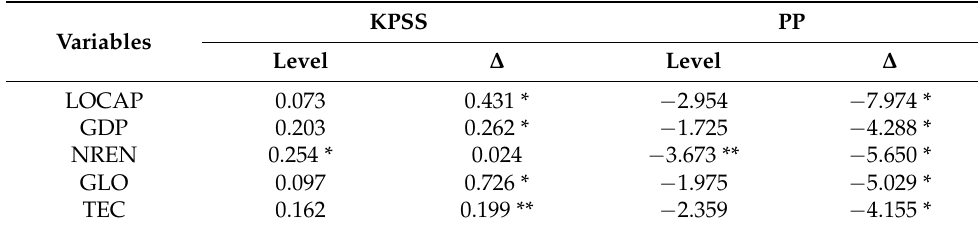
Table 3. ADF and PP tests.